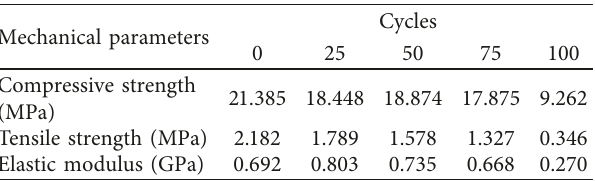
Table 4: Mechanical parameters of cement mortar during freeze- thaw cycles